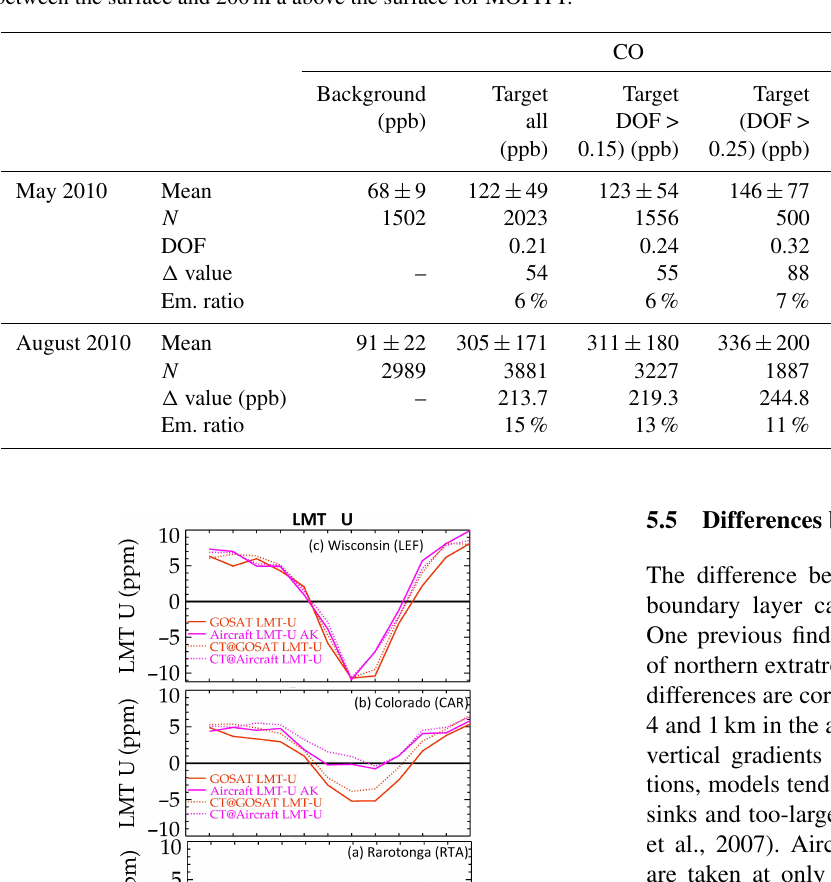
Table 7. Enhancements in CO and CO 2 for May and August, 2010. The target box is 11 to 18 ◦ S, 60 to 56 ◦ W, for May and 13–17 ◦ S, 55–60 ◦ W, for August. The CO background box is 11 to 18 ◦ S, 40 to 44 ◦ W, for May and 157.8–161.8 ◦ W, 19–23 ◦ S, for August. Rarotonga aircraft measurements are used for CO 2 background. The different CO target columns are for different cutoffs for the degrees of freedom between the surface and 200hPa above the surface for MOPITT.